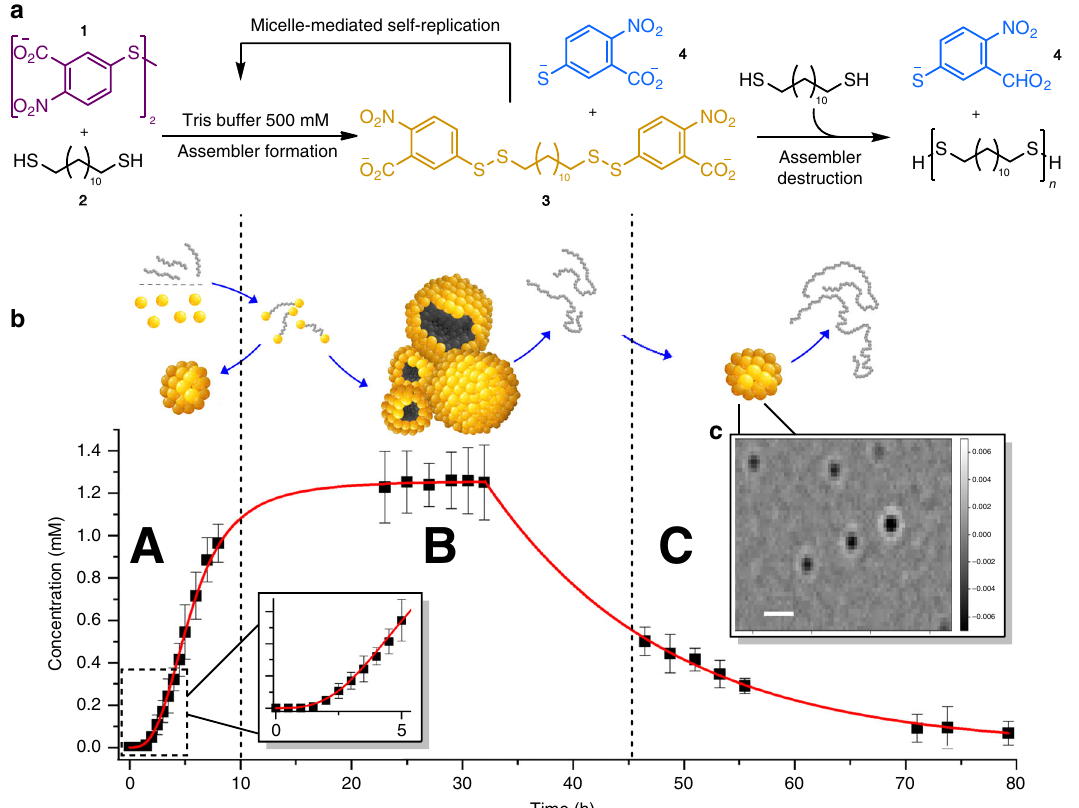
Fig. 2 Evolution of the concentration of molecular assembler building block over time. a , b The reaction between phase-separated disul fi de ( 1 ) and thiol ( 2 ) results in formation of (bola)amphiphilic compound 3 that self-assembles into supramolecular micelles (A). These micelles aid in solubilizing the apolar thiol into the aqueous layer, thereby creating an autocatalytic feedback (see insert). The assembler can also use the dissolved thiol in a second type of reaction, thereby producing disul fi de polymers. Although this reaction results in the destruction of its building block (compound 3 ), continued production